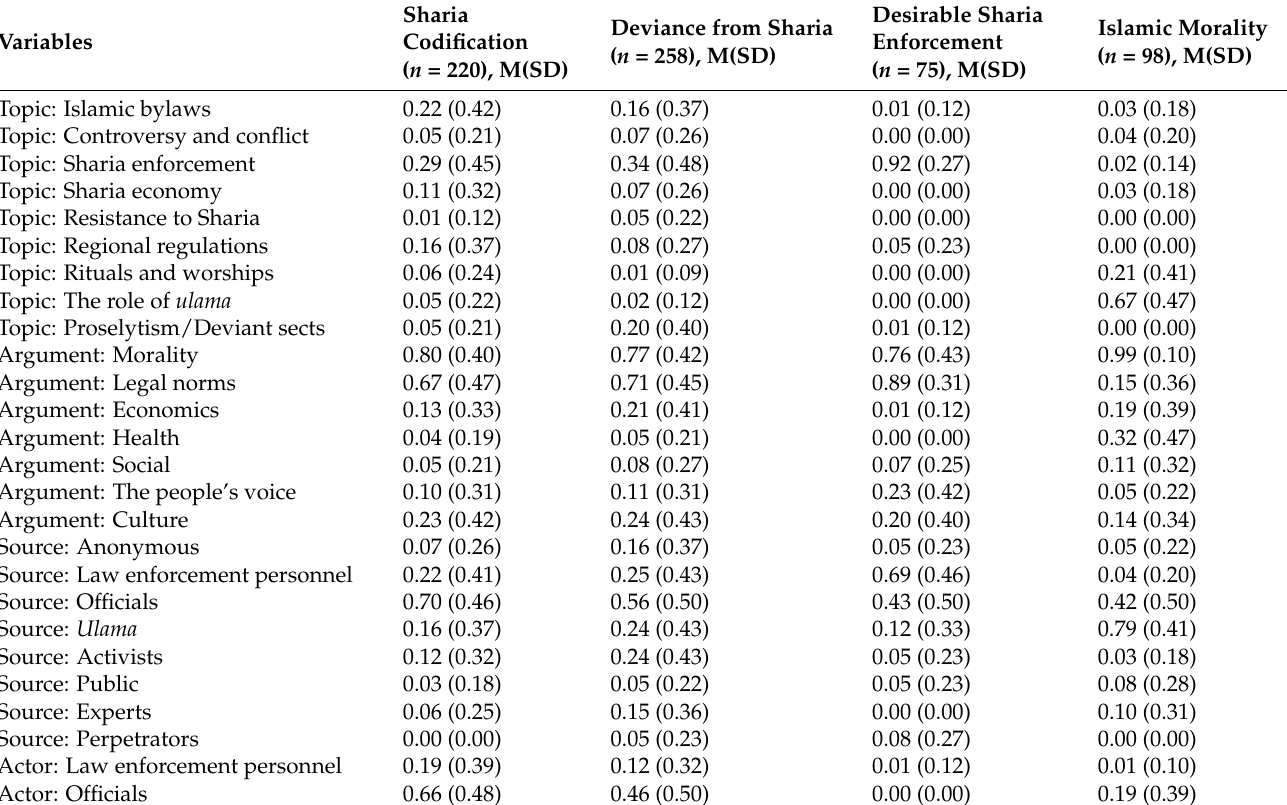
Table 1. The mean values and standard deviations for the four identified